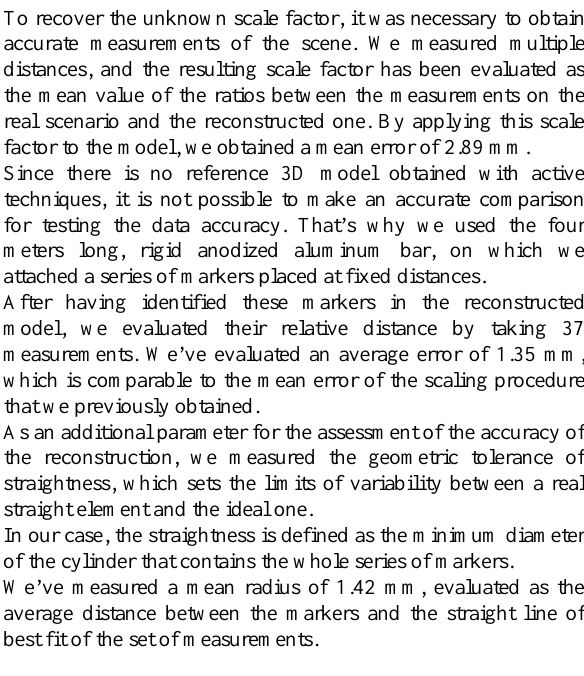
Figure 3. Markers placed